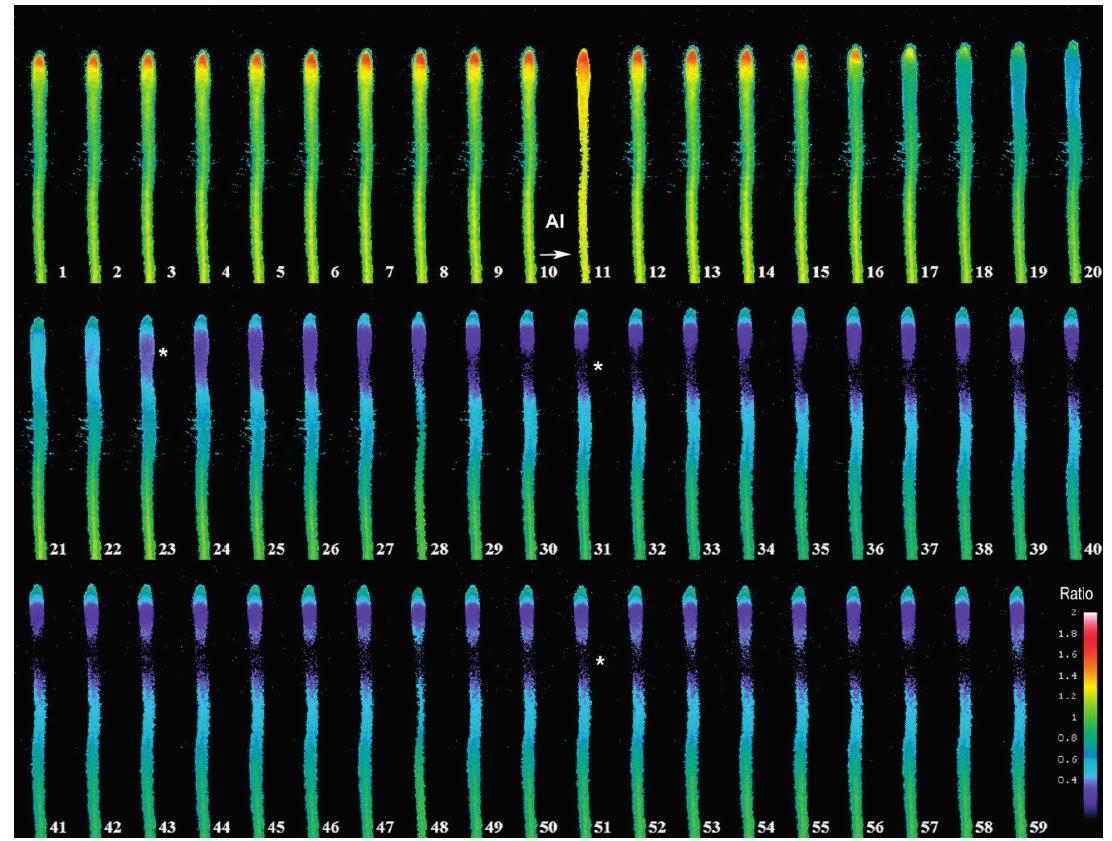
Figure 3. Exposure to Al (800 nM) induces dramatic changes in intracellular H 2 O 2 levels in growing Arabidopsis roots. Note that H 2 O 2 levels are highest in the root tip, but that the elongation zone exhibits the strongest response to Al treatment. Furthermore, the differentiation zone, from where root hairs emerge, is also affected. The arrow indicates when the Al was added and the asterisks where the elongation zone is located. Images were acquired at 1-min intervals.